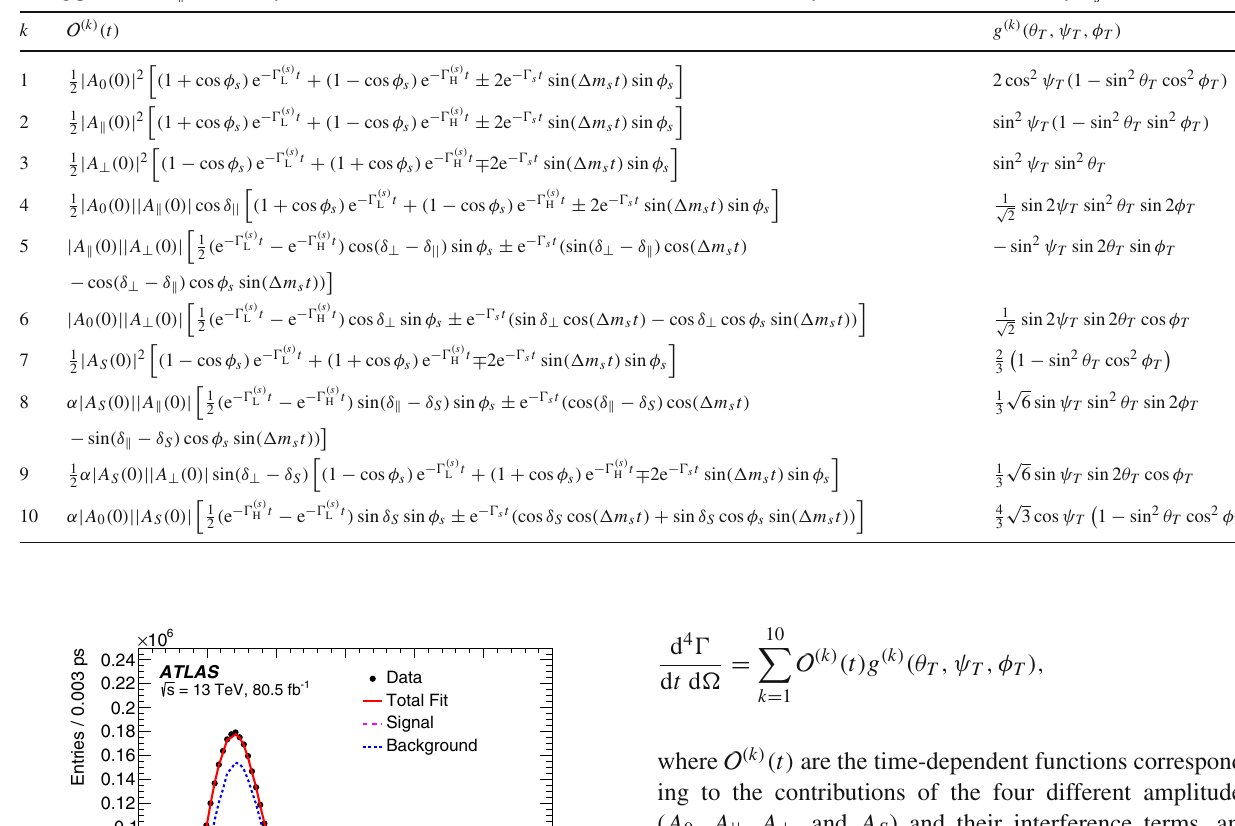
Table 4 The ten time-dependent functions, O ( k ) ( t ) and the functions of the transversity angles g ( k ) (θ T ,ψ T ,φ T ) . The amplitudes | A 0 ( 0 ) | 2 and | A (cid:10) ( 0 ) | 2 are for the CP -even components of the B 0 s → J /ψφ decay, | A ⊥ ( 0 ) | 2 is the CP -odd amplitude; they have corresponding strong phases δ 0 , δ (cid:10) and δ ⊥ . By convention, δ 0 is set to be zero. The S -